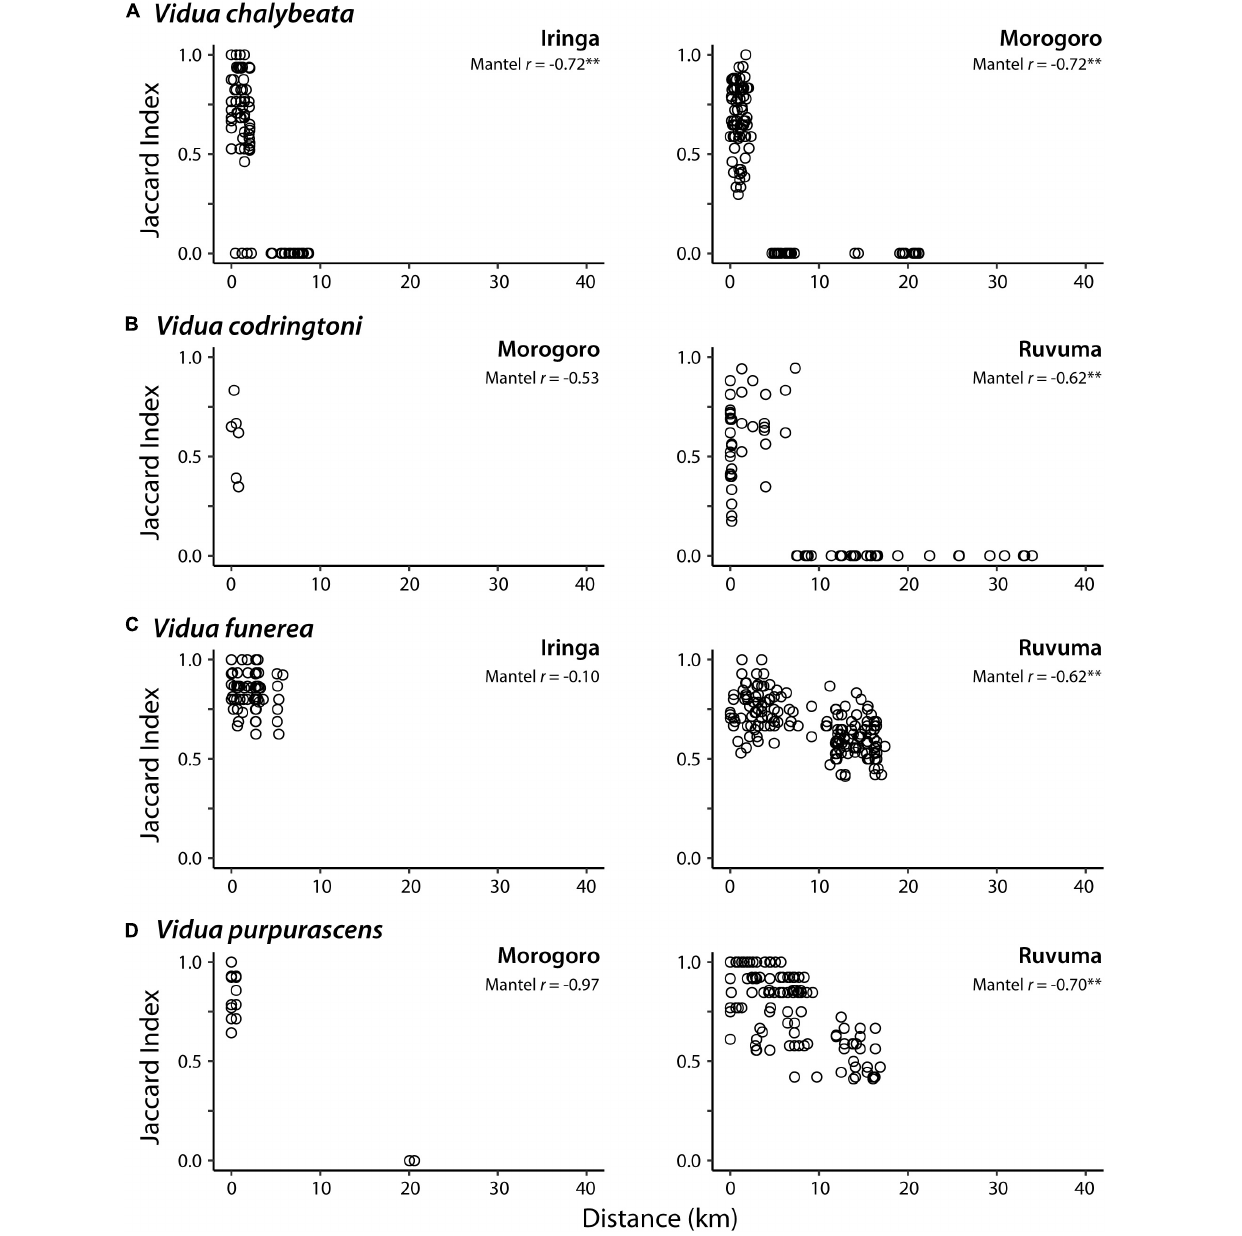
FIGURE 2 | Relationship between pairwise distance between call sites and non-mimicry song sharing (Jaccard index) for indigobird males in eight populations. Each species (A–D) was sampled from two of three regions: Iringa, Morogoro, and Ruvuma. Mantel r = Mantel coefficient; ∗∗ Q -value <